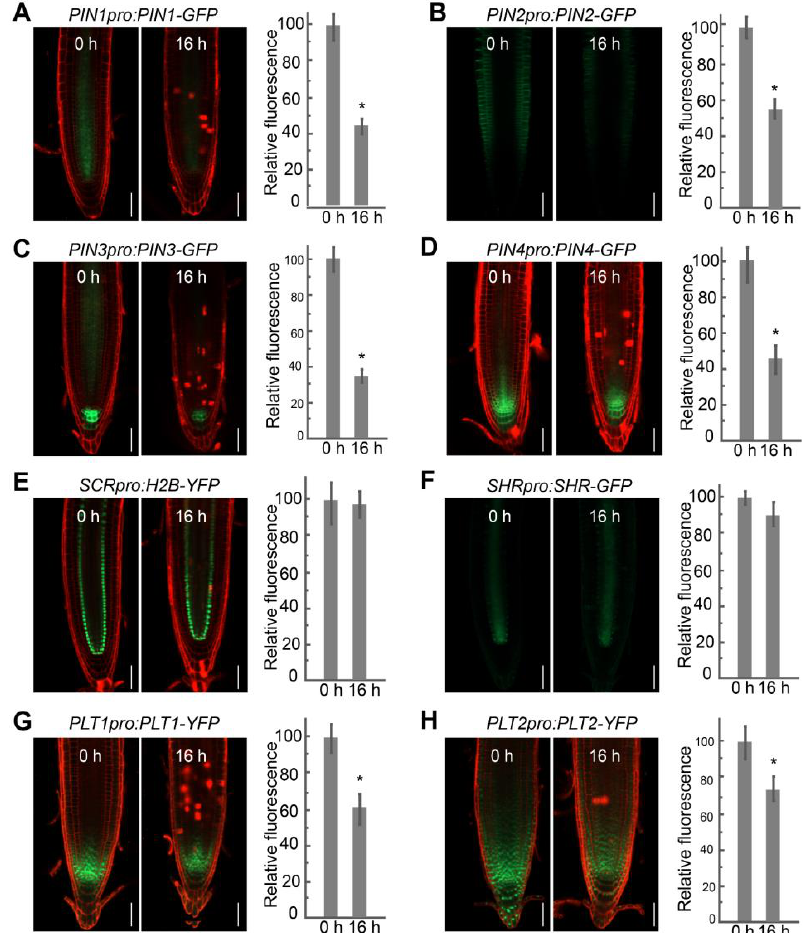
Figure 3. FB1 affects the abundance of PINs and PLTs. The localization pattern and quantification of fluorescence intensity (green) of PINs and stem cell niche markers treated with 2.5 μM FB1 for 0 and 16 h, respectively. The root tips were stained with propidium iodide (PI) (red). ( A ) PIN1pro:PIN1-GFP . ( B ) PIN2pro:PIN2-GFP . ( C ) PIN3pro:PIN3-GFP . ( D ) PIN4pro:PIN4-GFP . ( E ) SCRpro:H2B-YFP . ( F ) SHRpro:SHR-GFP . ( G ) PLT1pro:PLT1-GFP . ( H ) PLT2pro:PLT2-GFP . Data are means ± SD. Asterisk (*) denotes significant difference relative to seedlings without FB1, as deter- mined by t -test; p < 0.01. Scale bars, 50 μm.